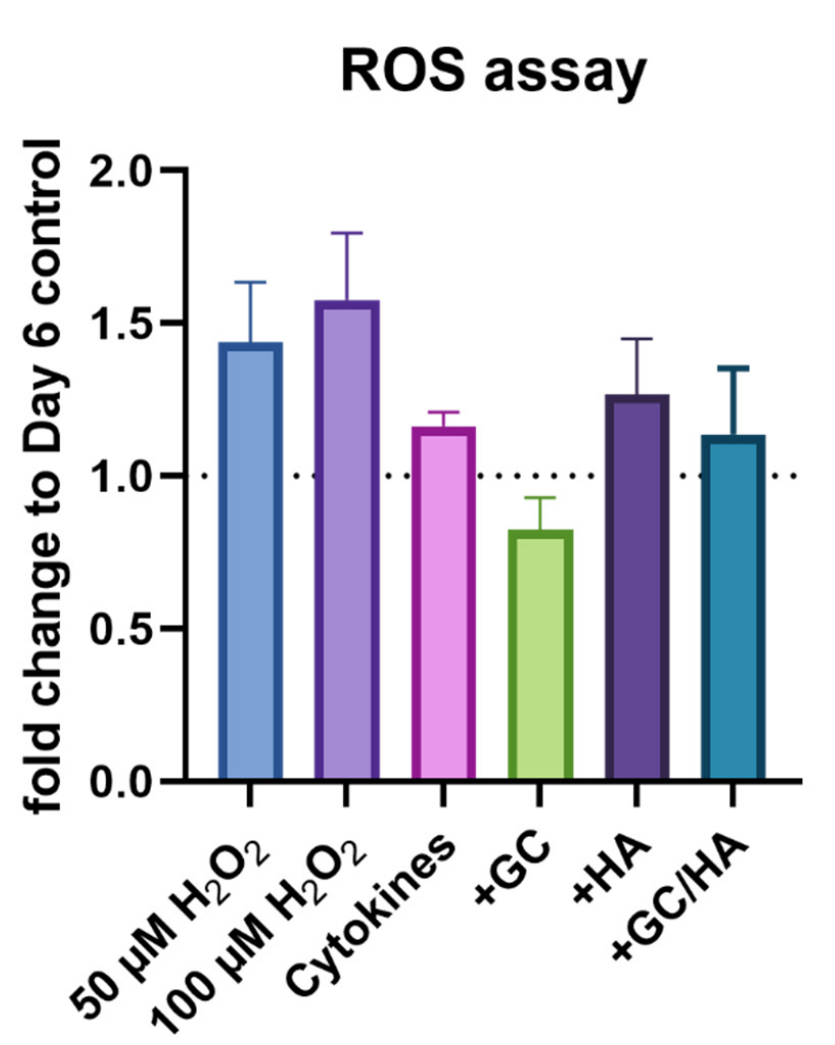
Figure 2. Measurement of ROS after a 3-day incubation with cytokines followed by 3-day treatment with cytokines with and without supplementing test substances (10%). In addition, two positive controls were analyzed with H 2 O 2 . The dotted line represents the control group on day 6.